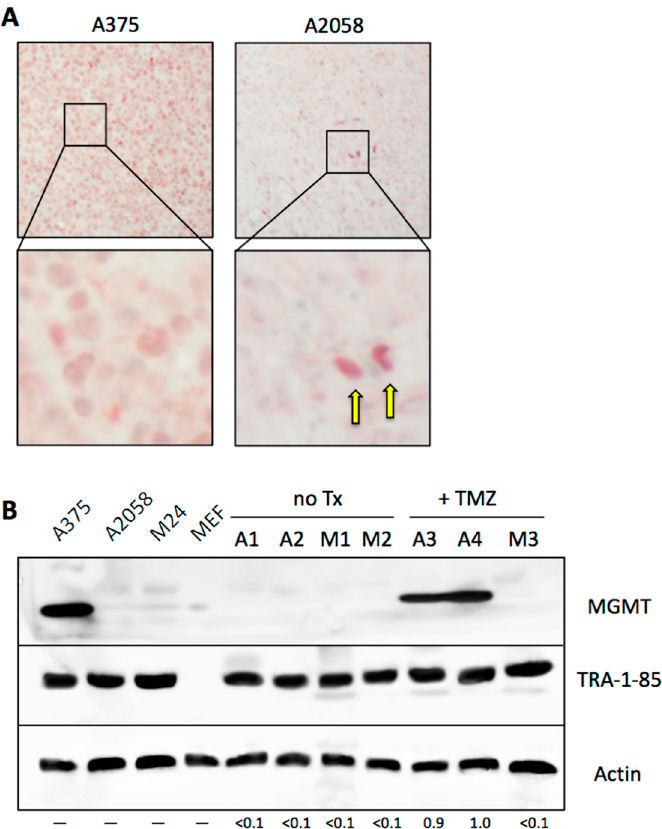
Figure 10. MGMT expression in tumor tissue. ( A ) Nude mice were injected subcutaneously with 4 × 10 6 MGMT-positive A375 cells or with MGMT-negative A2058 cells. Once pea-sized tumors had